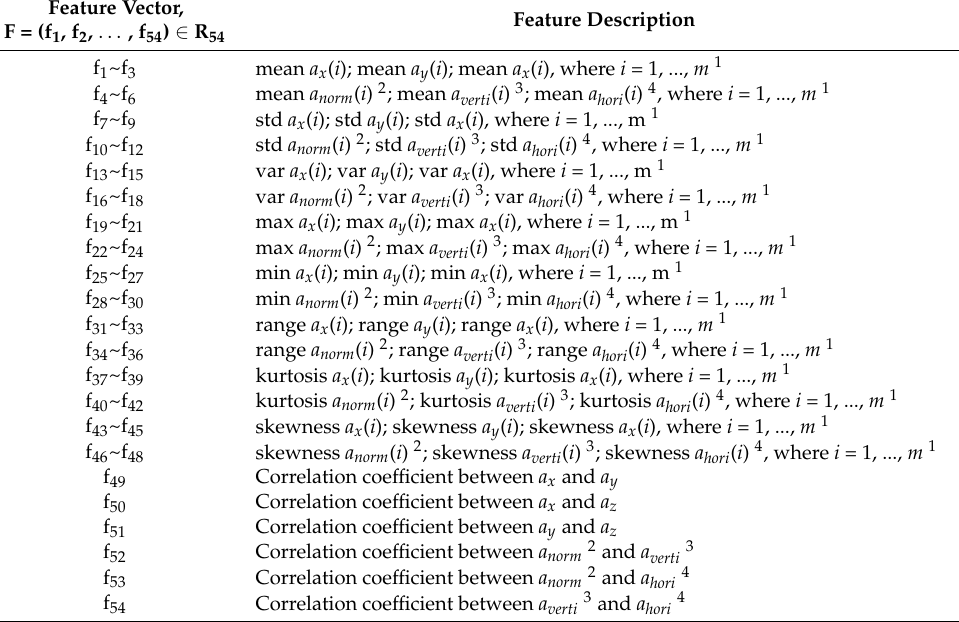
Table 3. The feature vector for the knowledge-based fall detection algorithm.